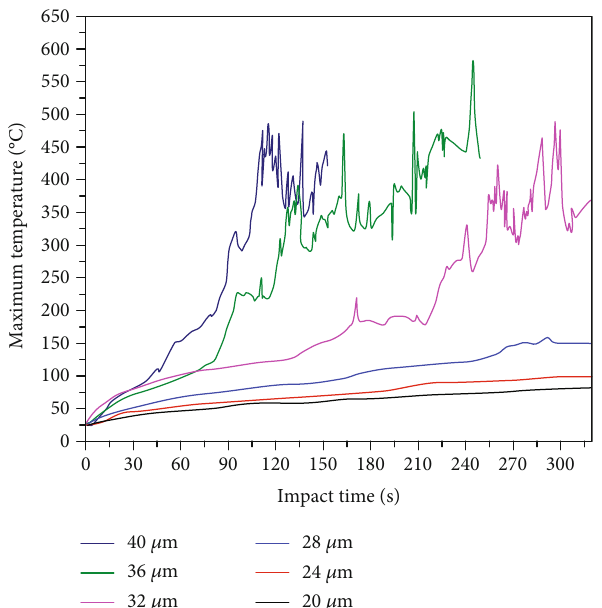
Figure 5: Maximum temperature-time curves under UHF impact with di ff erent impact amplitudes.